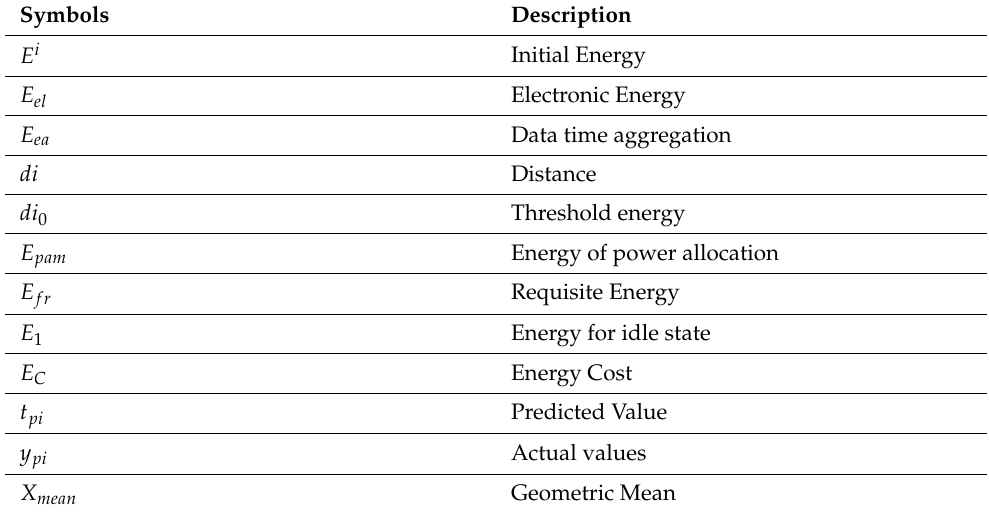
Table 2. List of Symbols.